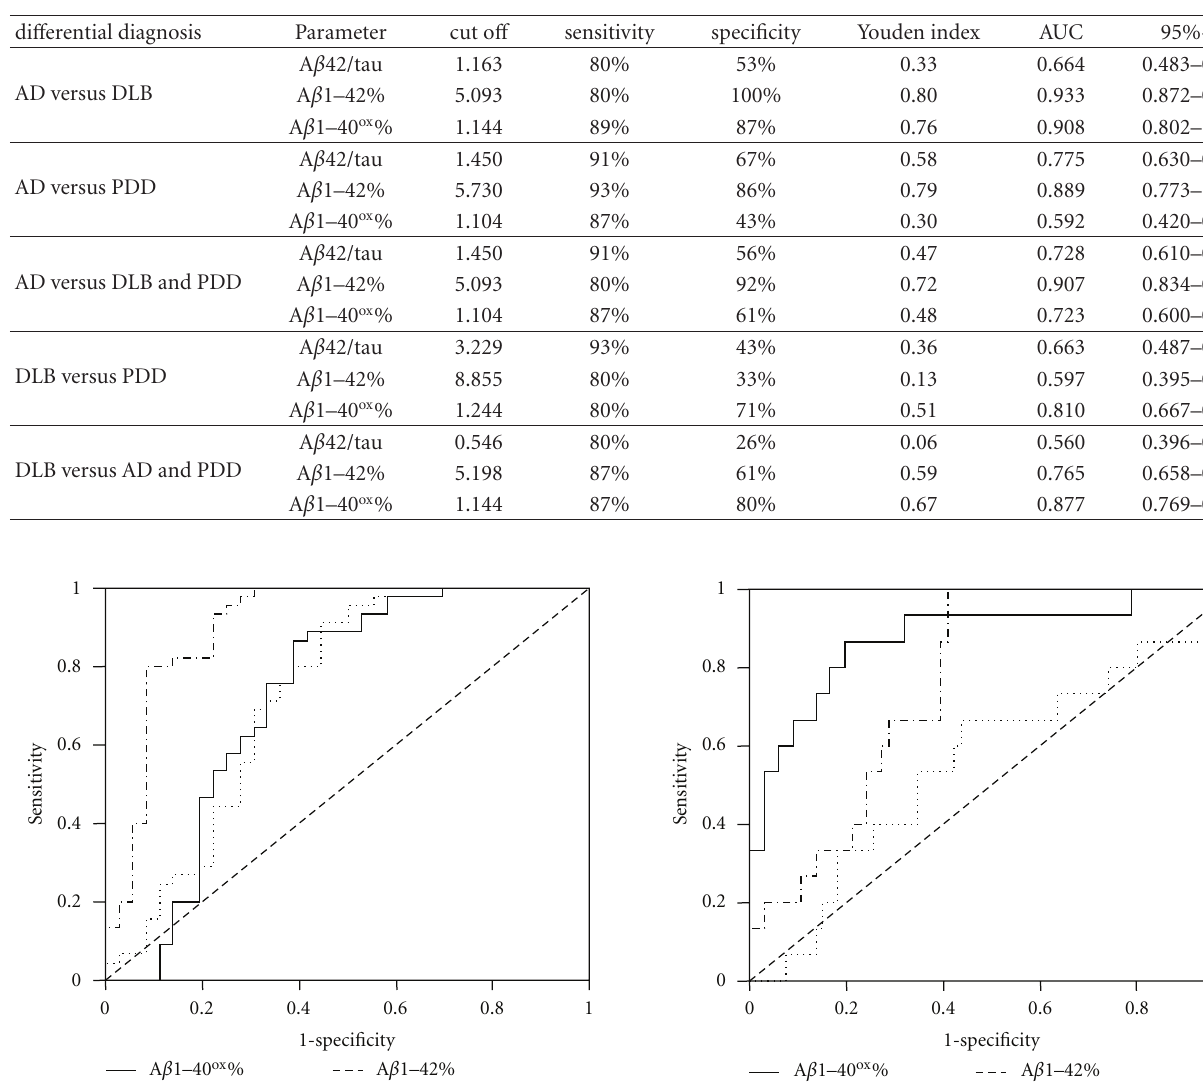
Table 2: Cuto ff points, sensitivities, and specificities.